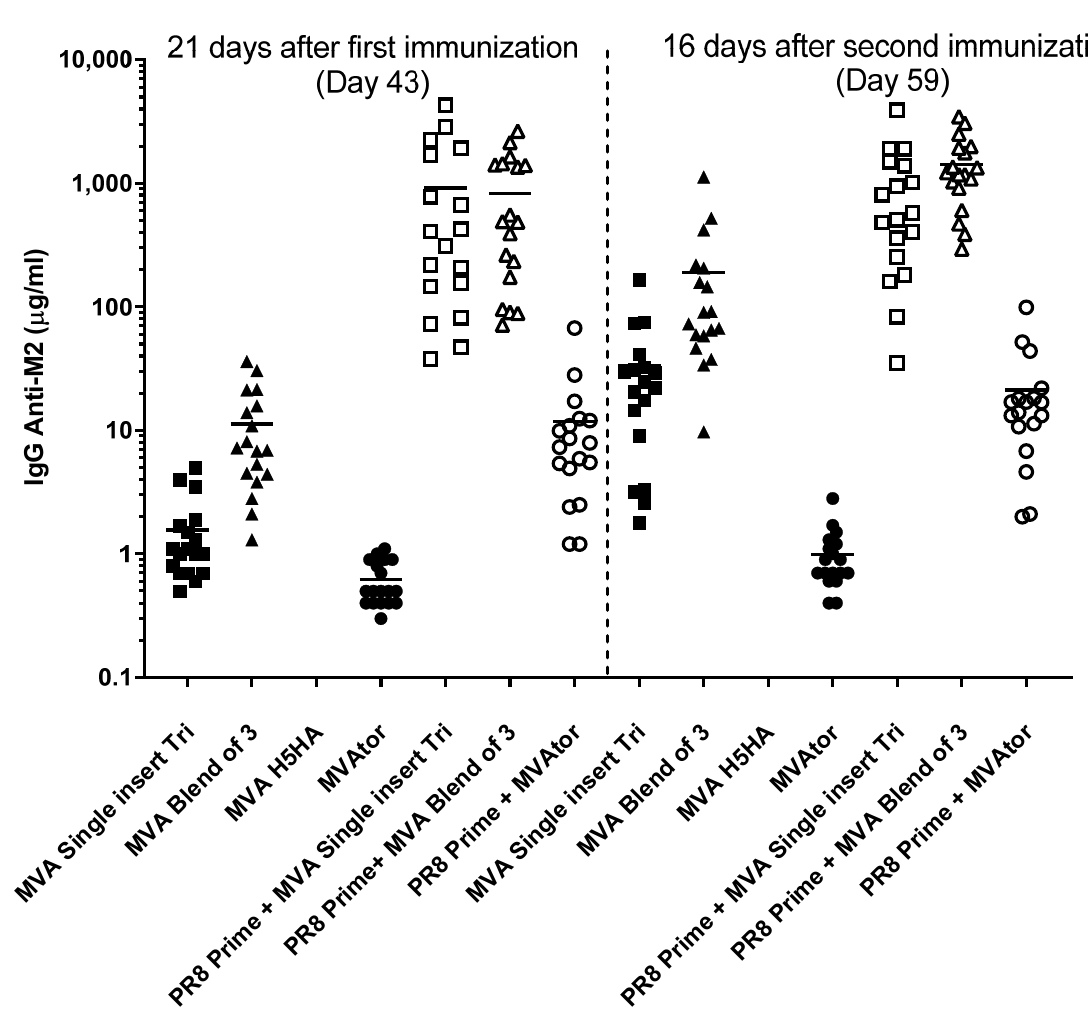
Figure 7. Anti-M2 IgG immune response in mice that received vaccines that encoded METRC antigen (Immunization days: Optional prime day 0, MVA Day 22 and Day 43). “PR8 Prime” refers to intranasal installation of sublethal PR8 on day 0; first immunization using an MVA vaccine occurred on day 22; second immunization using MVA vaccines occurred on day 43. For virus-primed mice, serum anti-M2 IgG antibody levels did not increase beyond the primed and boosted level despite an additional immunization. Squares depict single insert encoding M1 + METRC + NP; triangles depict a blend of individual M1, METRC and NP constructs; circles depict MVAtor controls. Filled symbols depict MVA vaccine treatments; empty symbols depict non-lethal PR8 infection as a priming event. M2e 9mer peptide VETPIRNEW [28] and the entire M2e peptide (SLLTEVETPIRNEWGCRC- NGSSD) were weak recall antigens, with 38 ± 18 spots and 26 ± 18 spots per 300,000 cells (Table 3). Despite weak cellular immunity, anti-M2 IgG serum levels at the same timepoint were 320 ± 306 µ g/mL, indicating antibody immunity to M2 protein. Full-length M2 protein or Class I peptides of M2 internal domains (negative controls) did not recall positive ELISpot results (10.6, 6.7 and 2.7 spots). Data are summarized in Table